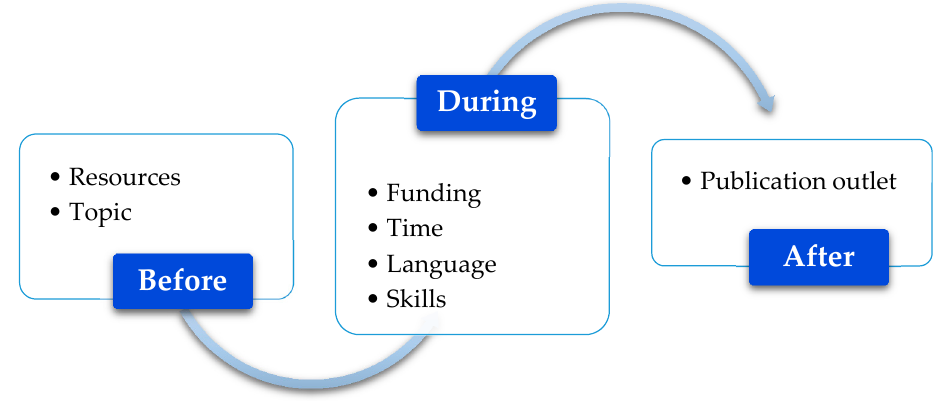
Figure 1. Obstacles to publication.